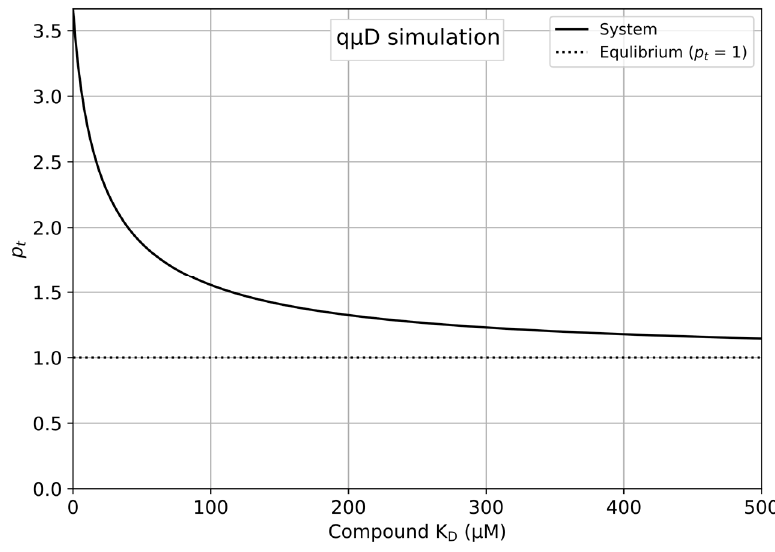
Figure 2. The protein–ligand complex K D vs. the p t. standard microdialysis system, 100 µL red chamber, 300 µL white chamber, [t0] = 80 µM and [l0] = 50 µM. At higher concentrations, the ratio